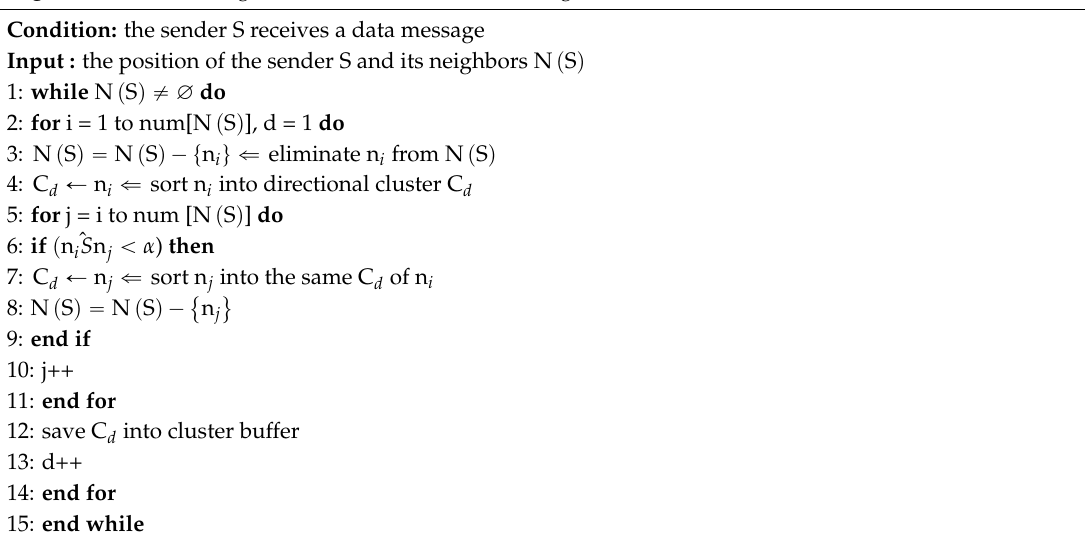
Algorithm 1. Vector-angle-based cluster classification